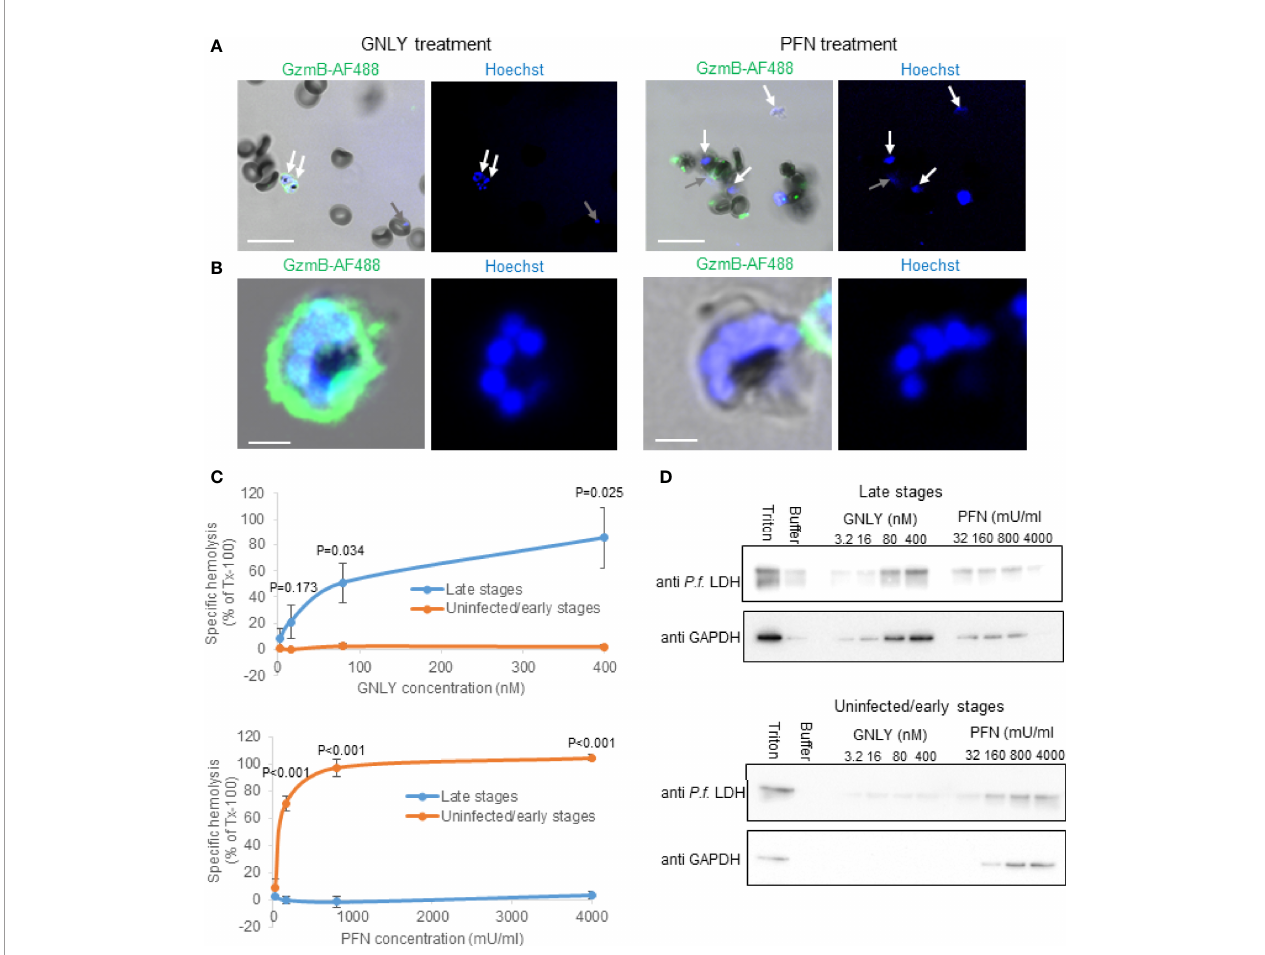
FIGURE 1 | Plasmodium falciparum infections render parasitized RBCs susceptible to GNLY while they become simultaneously resistant to PFN lysis. (A, B) , non- synchronized iRBCs cultures were treated with Alexa Fluor 488-labeled GzmB (0.4 m M) in combination with GNLY (0.4 m M) or with PFN (500 mU/ m l) for 20 minutes before fi xation and assessment by confocal microscopy. Nuclei were stained with Hoechst and are indicated in blue. Late stage parasites are indicated with white arrows and early stage parasites with gray arrows. Scale bars are 10 m m in (A) and 2 m m in (B) MACS-puri fi ed (late stages) and fl ow-through cells (uninfected and early stages) were treated with indicated concentrations of GNLY and PFN for 15 minutes at 37°C before centrifugation to separate the cellular pellet from the supernatant. The supernatants were subjected to optical densities measurement at a wavelength of 405 nm to assess hemoglobin release (C) and to immunoblot analysis to monitor release of plasmodial LDH and RBC GAPDH (D)